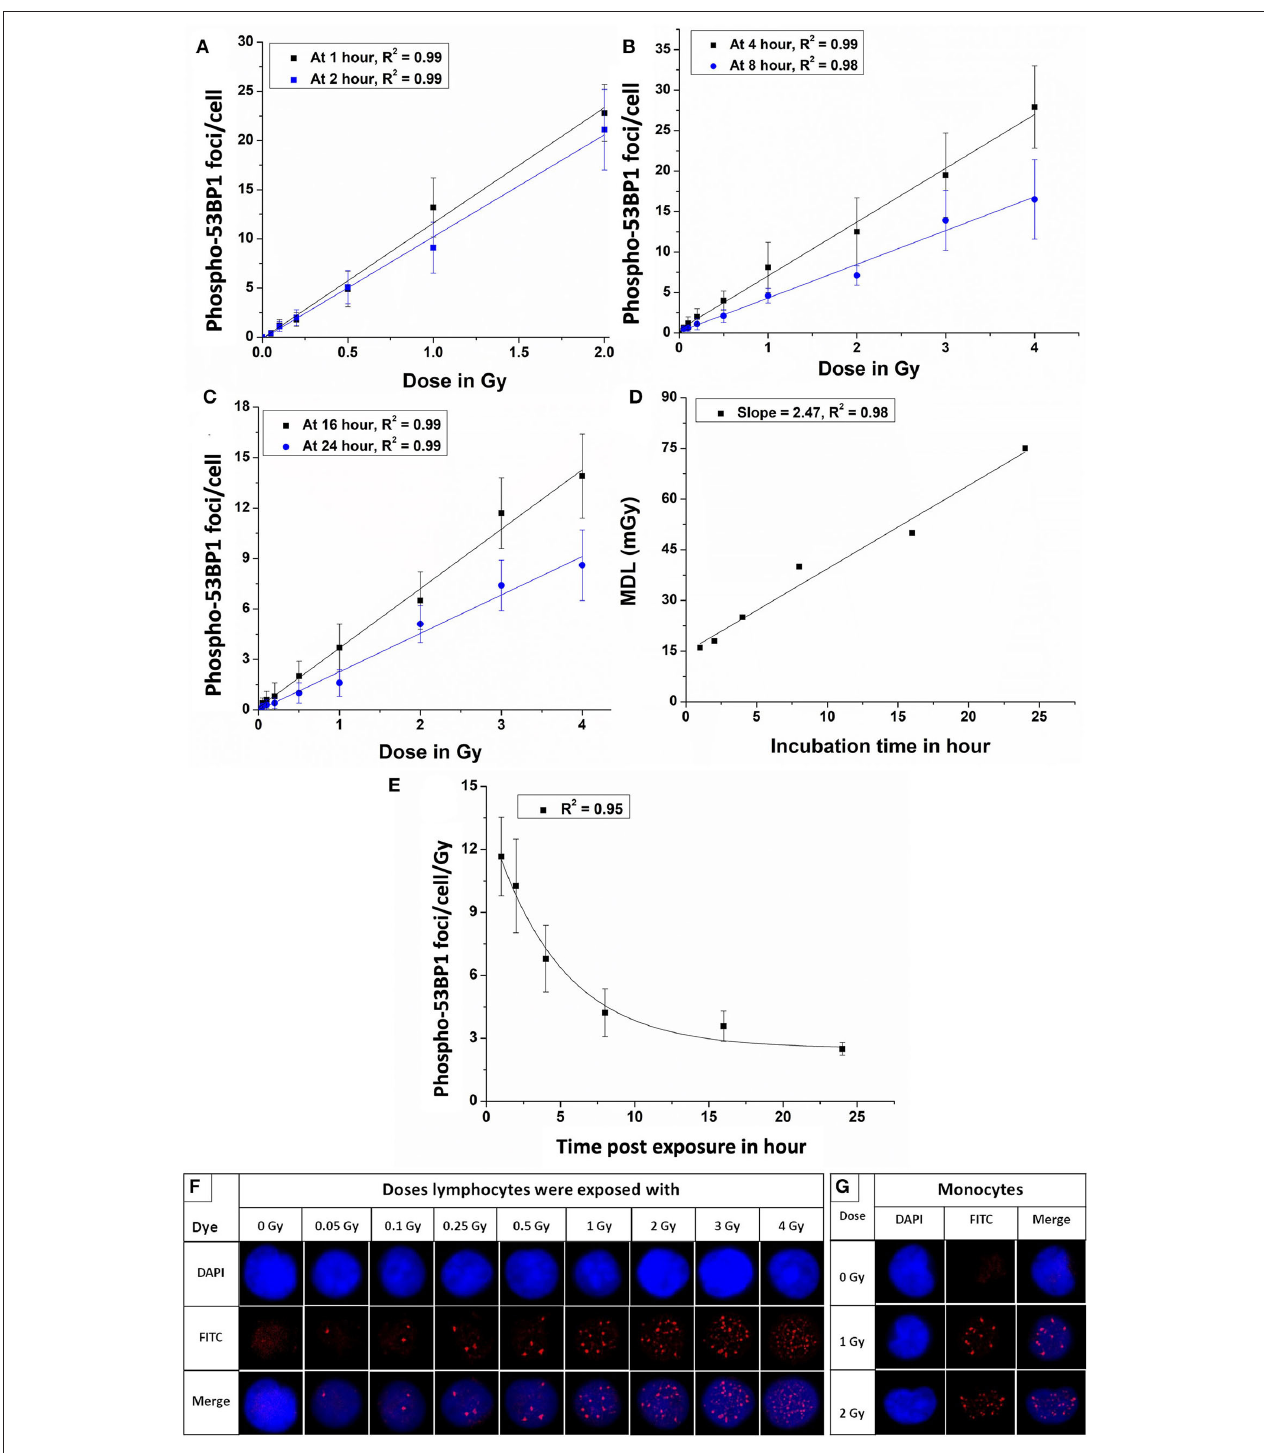
FIGURE 3 | Dose-response curves for 60 Co- γ -rays-induced-phospho-53BP1 foci formation post-irradiation incubation of (A) 1 and 2h (B) 4 and 8h (C) 16 and 24h. (D) Estimated minimum detection limits of the dose-response curves established at 1, 2, 4, 8, 16, and 24h of incubation, following ISO recommendations (3 sigma of the background frequency) (E) Variation of the slope (53BP1 foci/cell/Gy) of the established dose-response curves, generated at 1, 2, 4, 8, 16, and 24h of incubation, post-irradiation. (F) Microscopic images showing an increasing number of phospho-53BP1 foci in the nucleus of PBLs with increasing doses (0 to 2.0Gy after 1h and 3 and 4Gy after 4h of incubation, post irradiation). (G) Representative images of monocytes (kidney-shaped nucleus) with and without 53BP1 foci (these cells were excluded from the scoring of 53BP1 foci).